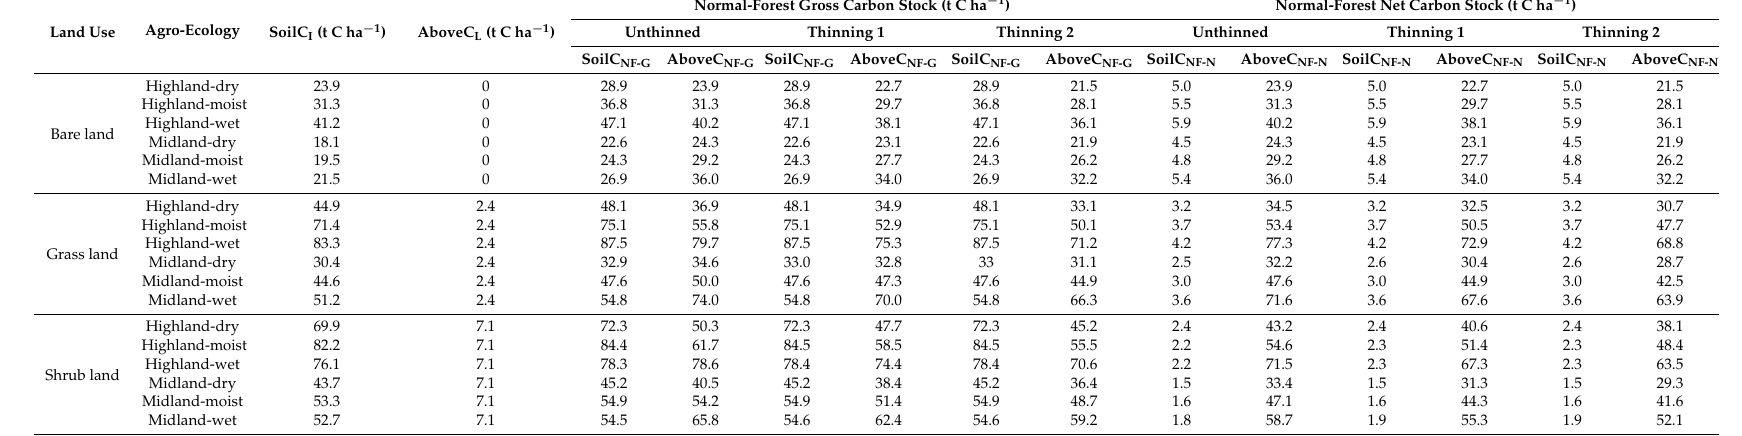
Table 4. Model predicted carbon sequestration potential through reforestation in a ‘Normal-forest’ system with a 100 year rotation period for different current land uses, in different agro-ecological zones and under different managements. Initial soil carbon (SoilC I ) and aboveground carbon (AboveC L ) are obtained as described in Table 1. Normal-forest gross carbon stock (SoilC NF-G , AboveC NF-G ) is derived by summing model predicted carbon stock from year 0 to 100 and divided by the rotation period (100 year). Net carbon stock (SoilC NF-N , AboveC NF-N ) is the difference between gross carbon stock and the corresponding initial carbon stock (SoilC I and AboveC L